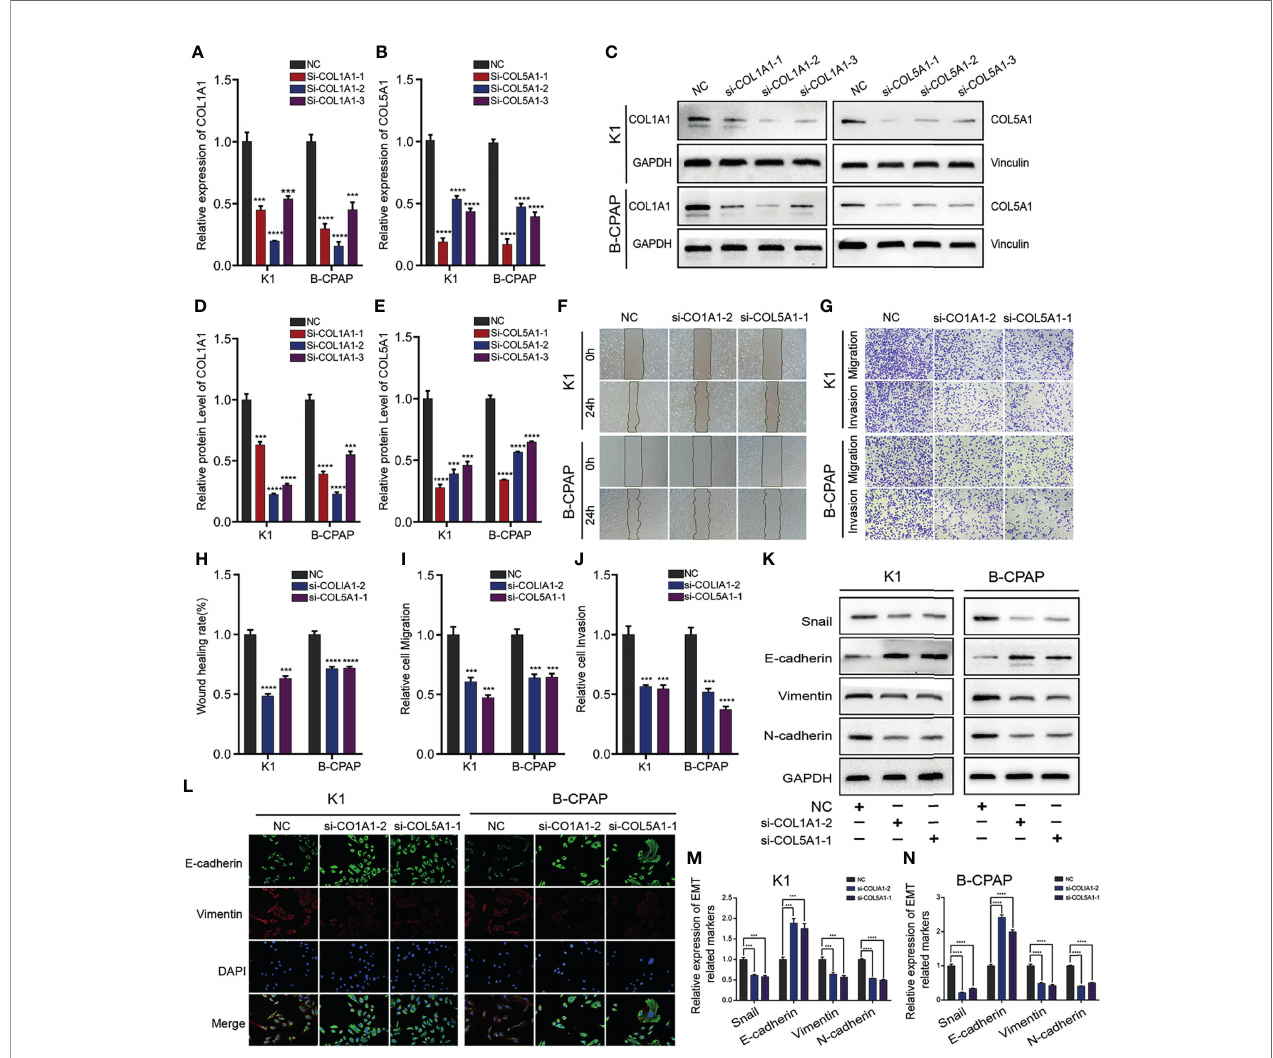
FIGURE 5 | Downregulating COL1A1 or COL5A1 expression can inhibit migration, invasion, and EMT in PTC cells. The knockdown ef fi ciency of COL1A1 and COL5A1 were analyzed by (A, B) qRT-PCR and (C – E) and Western blotting. Additionally, (F) wound healing and (G) Transwell assays were conducted to evaluate PTC cells migration and invasion, which proved that both si-COL1A1 – 2 and si-COL5A1 – 1 signi fi cantly impaired migration and invasion ability in K1 and B-CPAP cells. (H – J) The statistical results of wound healing assays and Transwell assays. (K) Western blot and (L) immuno fl uorescence analyses were performed to determine the expression of EMT-related proteins detection in PTC cells transfected with si-COL1A1 – 2 and si-COL5A1 – 1. (M, N) Western blotting assay showing the protein expression levels of EMT-related in PTC cells. In the fi gure, ***p < 0.001, ****p <